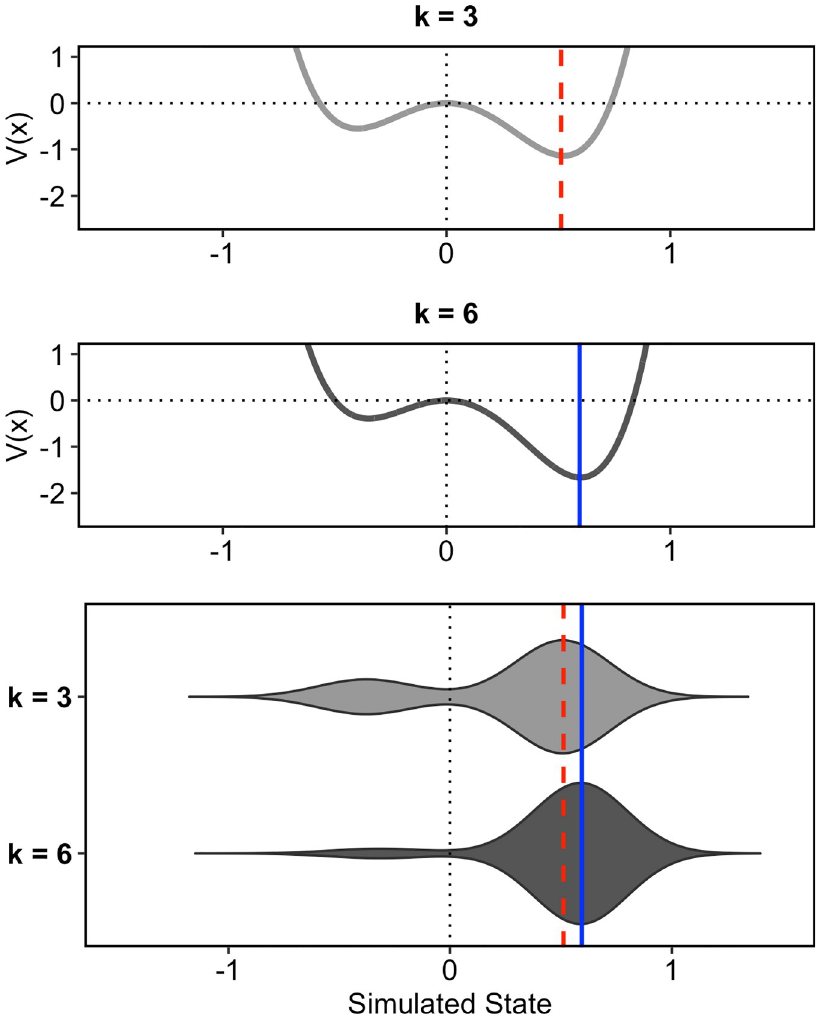
Fig 14. Another illustration of the simulation with different values for k. The first two panels from the top show the potentials for different values of the control parameter k . The lower panel gives the simulation results for these parameter values. The horizontal lines give the medians of the positive portions of the distributions, dashed/red for k = 3, solid/blue for k = 6.